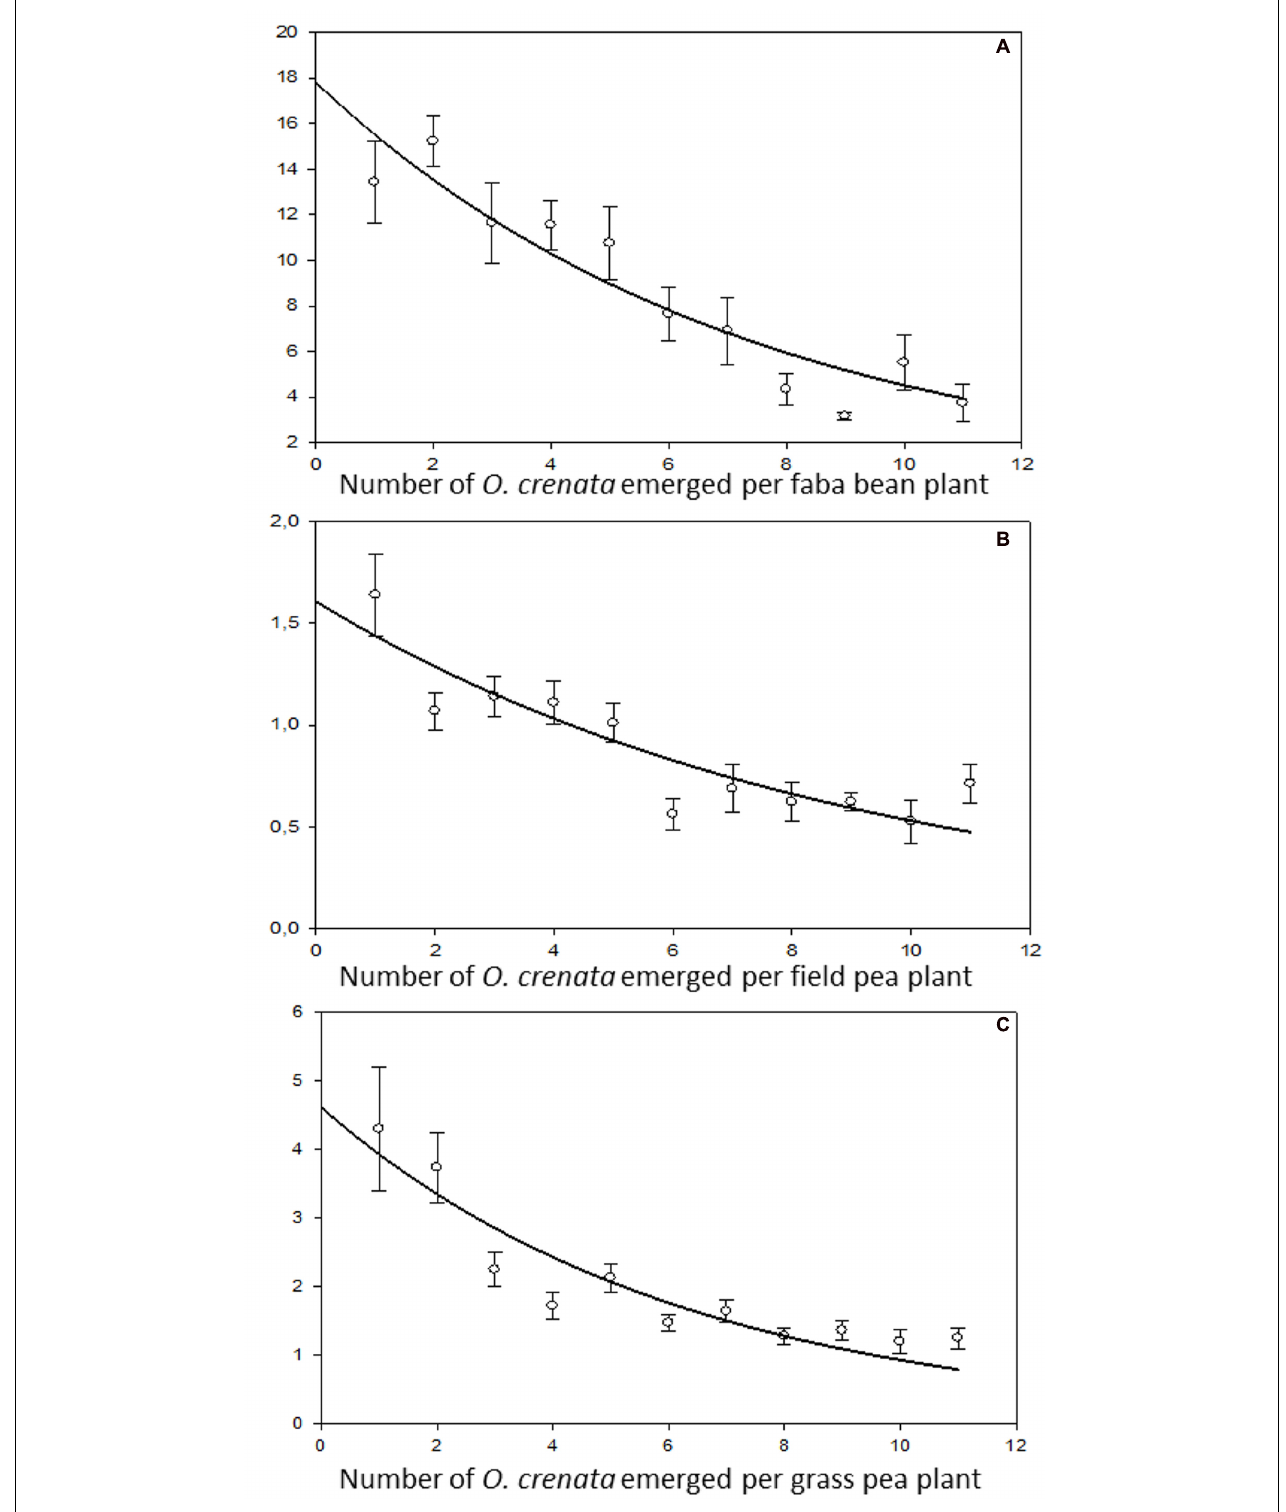
FIGURE 5 | Relationship between average dry weight of individual O. crenata plant and infection severity measured as O. crenata emergence per host plant. (A) Faba bean ( y = 17.82 e ( − 0 . 14x ) , r 2 = 0.89, P < 0.0001), (B) field pea ( y = 1.61e ( − 0 . 11x ) , r 2 = 0.80, P = 0.0002), (C) grass pea ( y = 4.62 e ( − 0 . 16x ) , r 2 = 0.85, P <